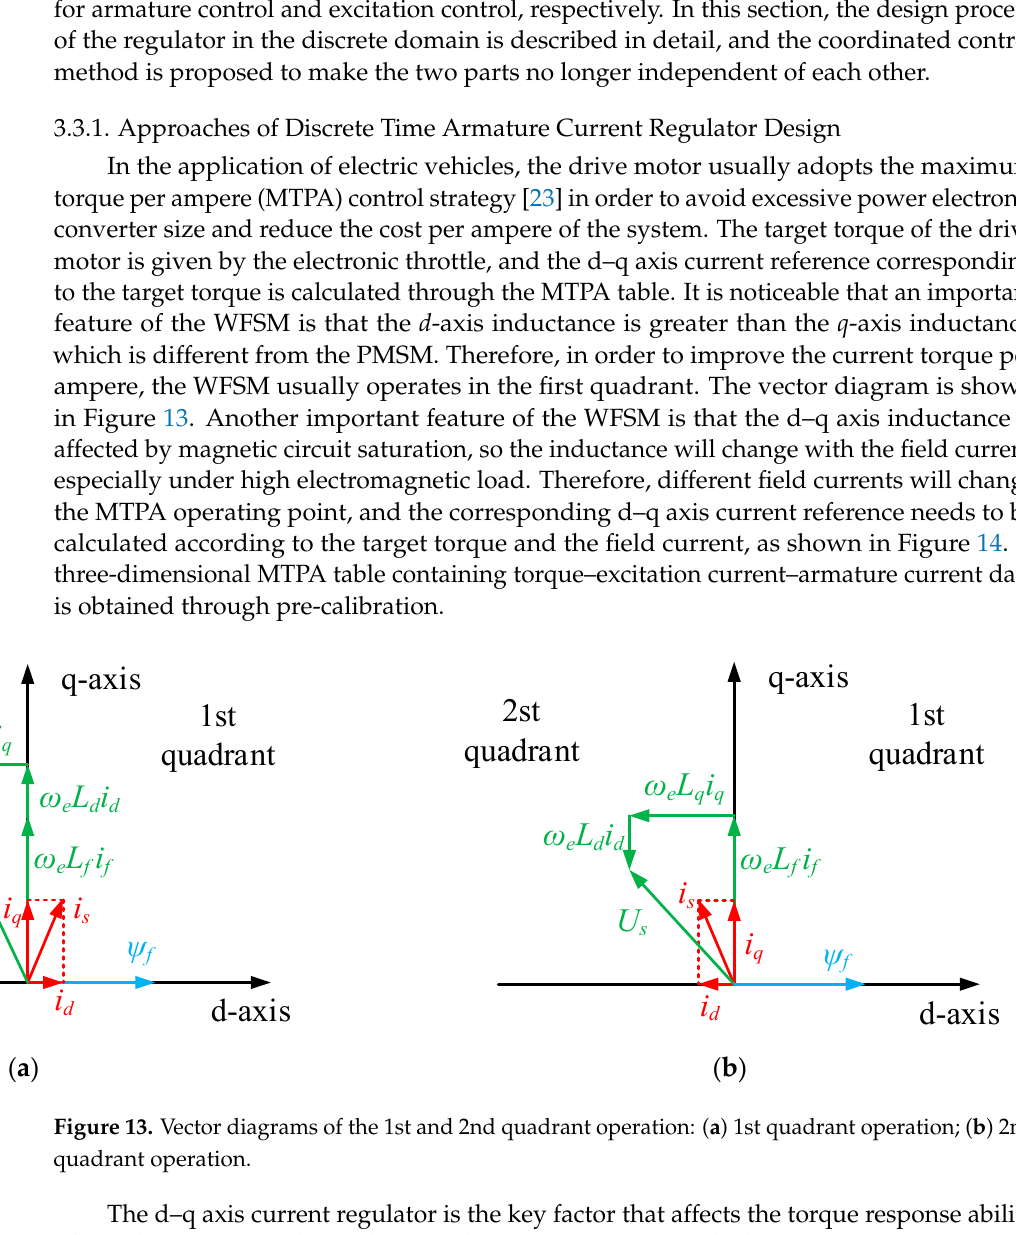
Figure 14. The block diagram of the current control system.